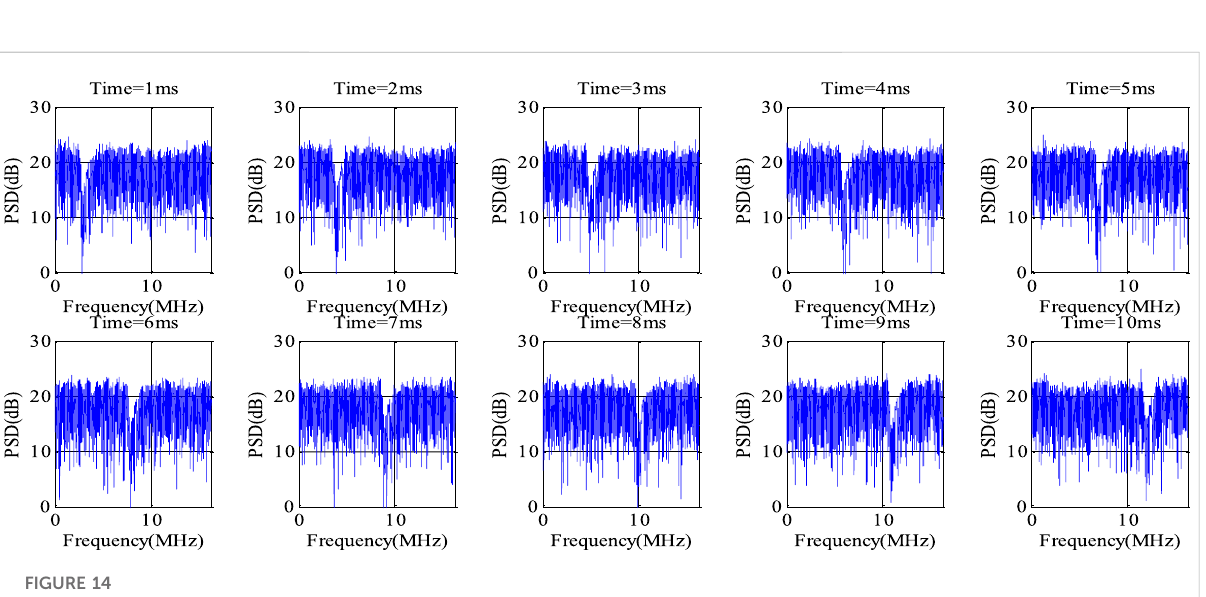
FIGURE 14 Spectral characteristics after anti-jamming based on timing reset